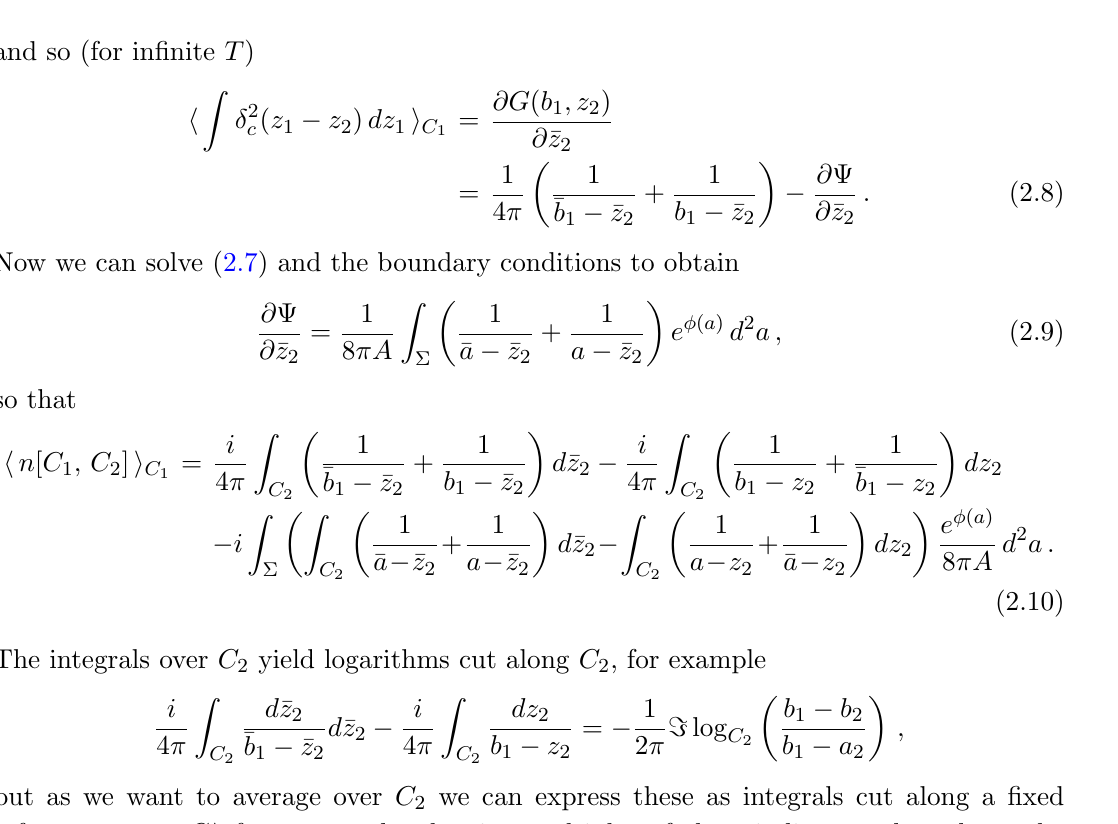
, C 2 and C (cid:3) illustrating (2.11). 1 2